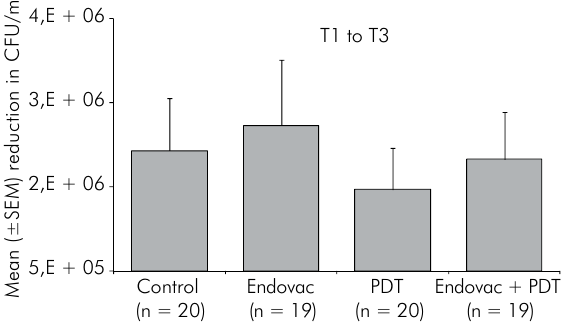
Figure 3. Bar chart of mean (±SEM) reduction in levels of C. albicans (CFU/mL-1) from pre-therapy (T1) to post-therapy, after intracanal medication